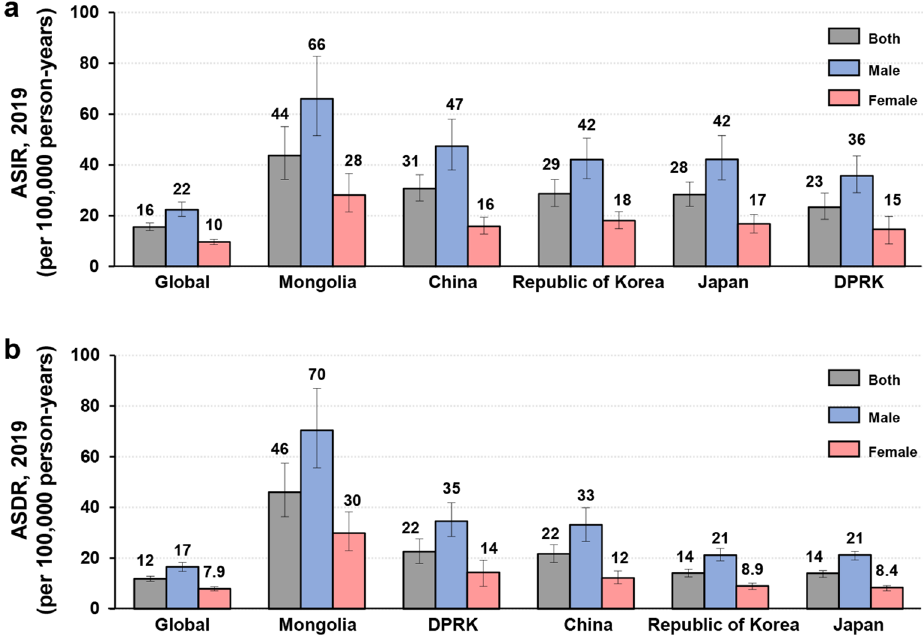
Figure 1. The ASIRs ( a ) and ASDRs ( b ) of gastric cancer worldwide and in five Asian countries in 2019 according to sex. ASDR, age-standardized death rate. ASIR, age-standardized incidence rate. Error bars indicate 95% uncertainty intervals.